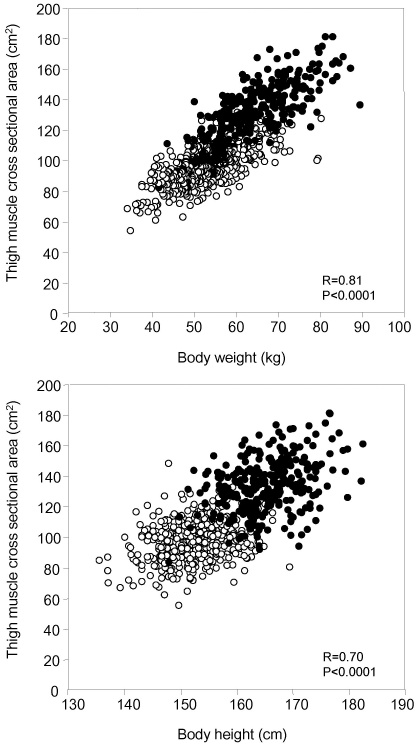
Scatter plots between thigh muscle cross-sectional area and body weight (top) and body height (bottom).•: men, ○: women.